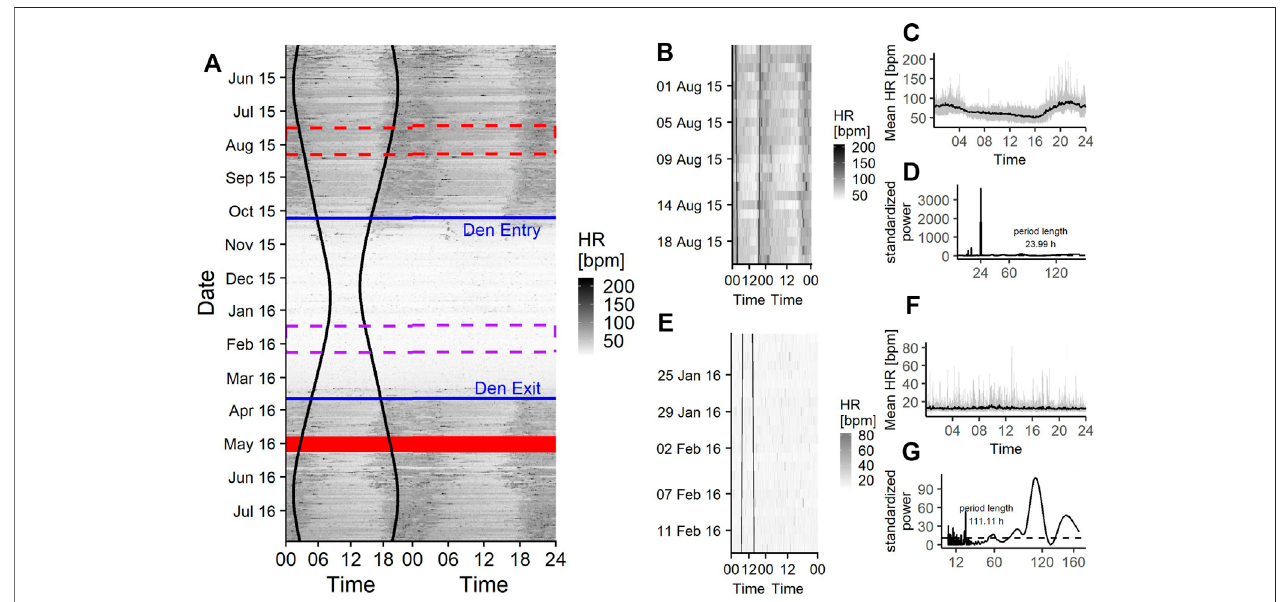
FIGURE 5 | (A) Doupleplot rasterplot of the raw heart rate (HR) data of a 7 year old male Brown bear ( Ursus arctos ) with measurements from 15th May 2015 – 31st July 2016. The x axis represents the time of day x (left) and x + 1 day (right) from midnight to midnight and the y axis represents the time of the year in days. Heart rate is visualizedwithacolorgradientfromwhitetoblackwithincreasingheartratevalues.Sunriseandsunsettimearerepresentedasblackverticallines,theexcluded14 days after capture (29th April 2016) are shown as a red ribbon and the den entry and den exit days are indicated as blue horizontal lines. The red and purple dashed rectanglearezoomillustrationsfora25-daystimespanduringtheactivestate (B) andhibernation (E) .Themeanheartrateduringthe25-daystimespansoveradayare shown in (C) and (F) and the corresponding Lomb-Scargle Periodograms and the period lengths for this time span are shown in (D) and (G) .